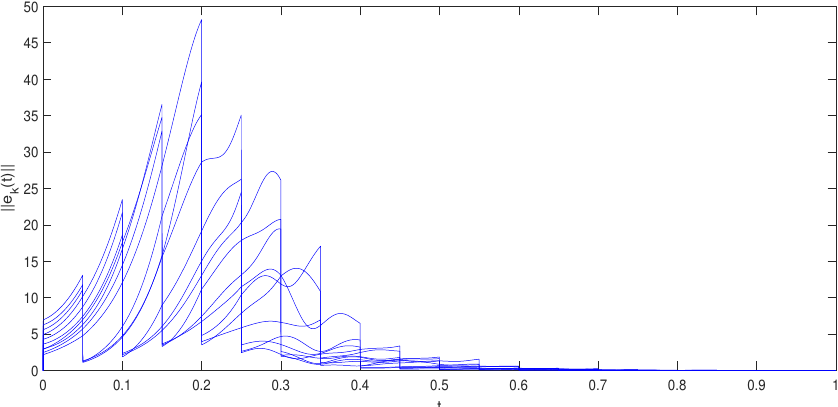
Figure 1. The orbits of the norm of synchronization errors (cid:107) e k ( t ) (cid:107) .